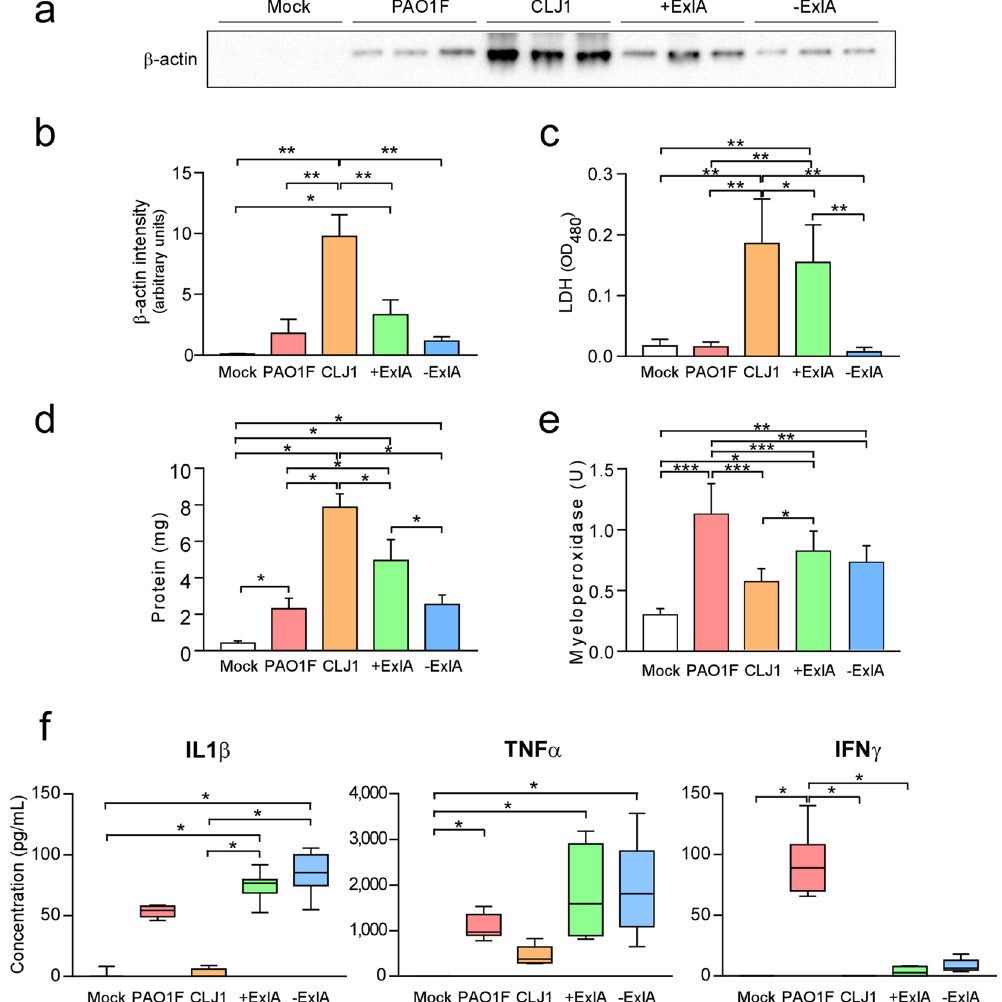
Figure 3. Intracellular proteins and pro-inflammatory cytokines in broncho-alveolar lavages. BALs were sampled at 18 h.p.i. after pulmonary infection with PAO1F, CLJ1, + ExlA or − ExlA (5 × 10 6 ), or mock infection with PBS, and were centrifuged to separate the cellular pellet from the soluble proteins. ( a ) Western blot analysis of β -actin in 3 BAL supernatants per condition (representative of 6–8 BALs per condition) and ( b ) histogram of band intensities. Statistics: ANOVA, p < 0.001; Holm-Sidak’s post-hoc test: * p = 0.031, ** p < 0.001. ( c ) LDH measurements in 6 BAL supernatants per condition. Statistics: ANOVA, p < 0.001; Holm-Sidak’s post-hoc test: * p = 0.028, ** p < 0.001. ( d ) Total proteins in BAL supernatants (n = 6). Statistics: ANOVA, p < 0.001; Holm-Sidak’s post-hoc test: * p < 0.001. ( e ) Myeloperoxidase activity in BAL pellets (n = 6). Statistics: ANOVA, p < 0.001; Holm-Sidak’s post-hoc test: *** p < 0.001, ** p = 0.003, * p < 0.05. ( f ) IL-1 β , TNF- α , and IFN- γ concentrations were measured in BAL supernatants (n = 6–8). Statistics: Kruskal-Wallis’s test, p < 0.001; Dunn’s post-hoc test: * p < 0.05. IL-10, IL-17 and IL-12p70 dosages yielded negligible values for all strains (not